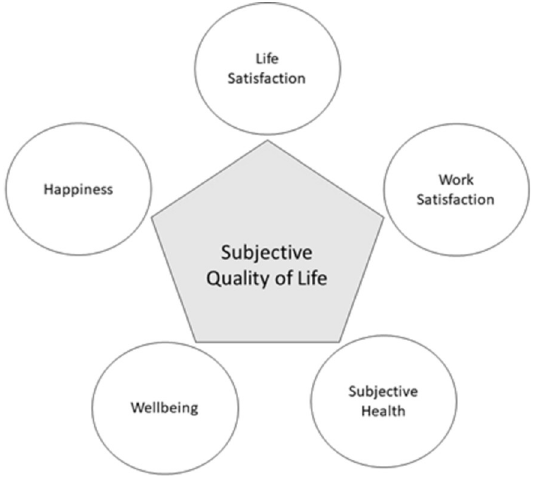
Fig 1. Subjective quality of life according to integrative quality-of-life (IQOL) theory. Note: Modified model of S ø ren Ventegodt et al. (2003:1032) integrative quality-of-life theory. The indicators for the five dimensions of quality of life refer to the indicators used in the Czech Household Panel